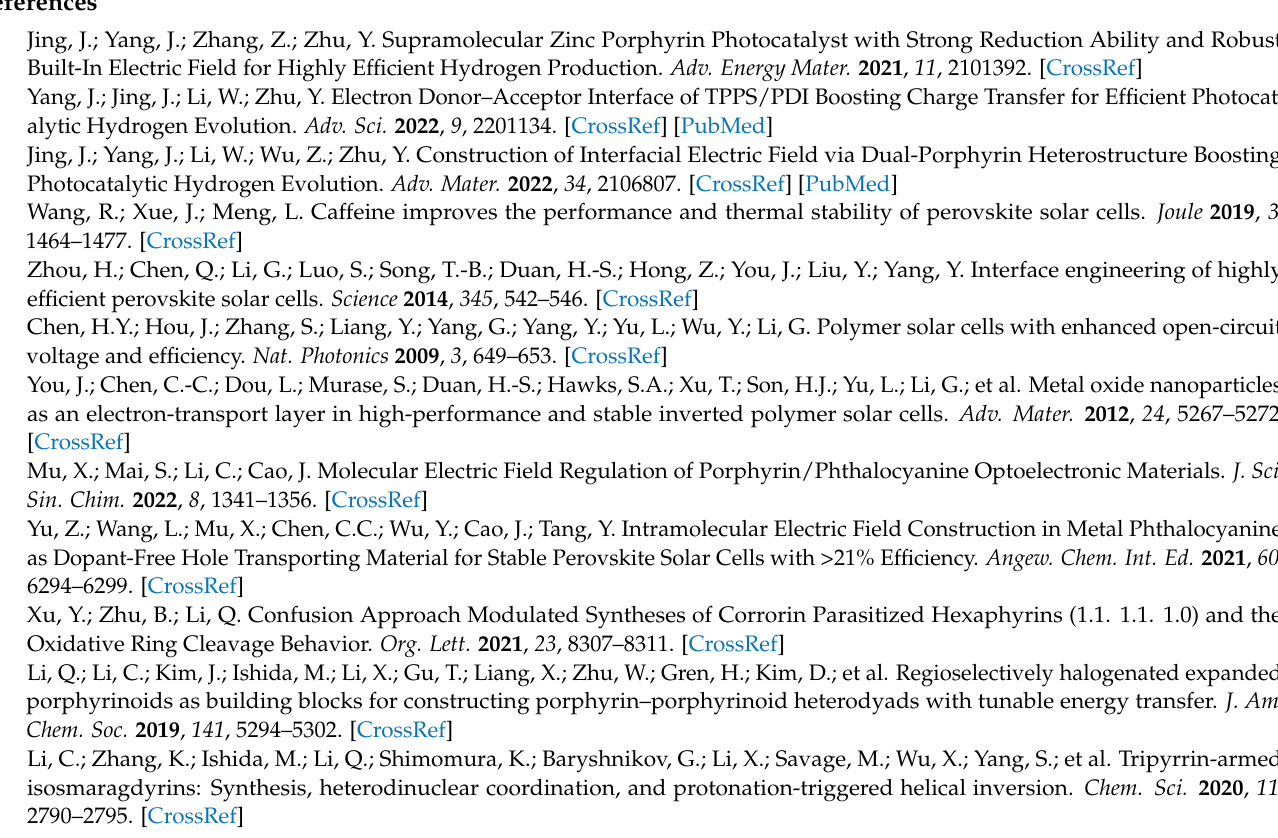
10.3390/molecules28041801/s1, Figure S1. UV-Vis absorption spectra of 6 molecules: (a) O7H, (b) O8H, (c) O9H, (d) OO7H, (e) OO8H, (f) OO9H. Figure S2. Electrostatic potential map of 6 molecules: (a) O7H, (b) O8H, (c) O9H, (d) OO7H, (e) OO8H, (f) OO9H. Figure S3. Electrostatic potential of 6 molecules from multiple angles. Figure S4. Electron-hole density map and transition density matrix of (a) O7H, (b) O8H, (c) OO7H, (e) OO8H, (d) OO9H. Figure S5. 3D and 2D diagrams of transition electric couple and magnetic dipole moment of O7H, O8H, O9H, OO7H, OO8H, OO9H. Figure S6. Electron circular dichroism of each molecule: (a) O7H, (b) O8H, (c) O9H, (d) OO7H, (e) OO8H, (f) OO9H. Figure S7. Front, back and bevel of dipole moments.: (a) O7H, (b) O8H, (c) O9H, (d) OO7H, (e) OO8H, (f) OO9H. Table S1. The dipole moments and dipole moment components of benzo [ghi] perylene of the compound, the side and the whole system are shown in the table. Table S2. MPI values for 6 molecules. Table S3. Energy level and energy gap difference of 6-molecule HOMO-LUMO. Table S4. Electronic excitation characteristic parameters of the main excited states of the six